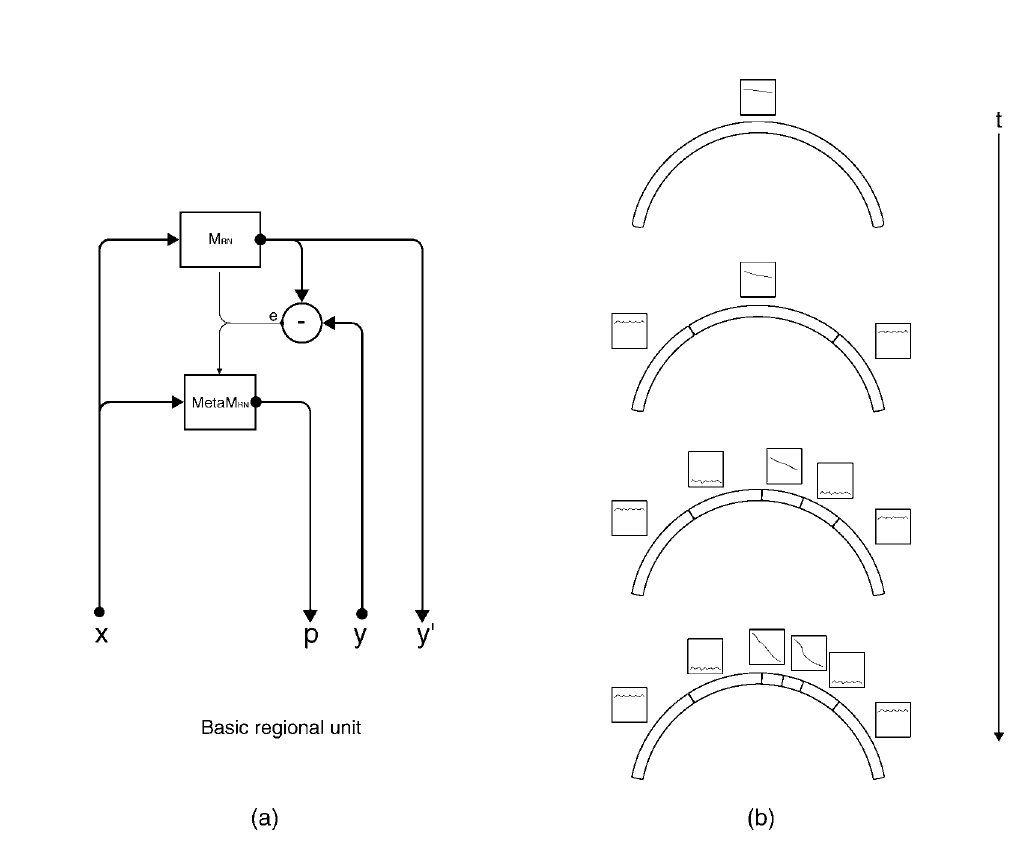
Figure 2. (a) An intrinsic motivation system is based on a population of regional units, each comprising an expert predictor M R that learns to anticipate the consequence y of a given sensorimotor context x belonging to its associated region of expertise R n , and a metapredictor metaM R progress of M R in the close past. The learning progress defines the interestingness of situations belonging to a given context, and actions are chosen in order to reach maximally interesting situations. Once the actual consequence is known, M R and metaM R get updated. metaM R re-evaluates the error curve linked with this context and computes an updated measure of the learning progress (local derivative of curve). (b) Illustration of the splitting/assignment process based on self-organized classification system capable of structuring an infinite continuous space of particular situations into higher-level categories (or kinds) of situations. An expert predictor/metapredictor circuit is assigned to each